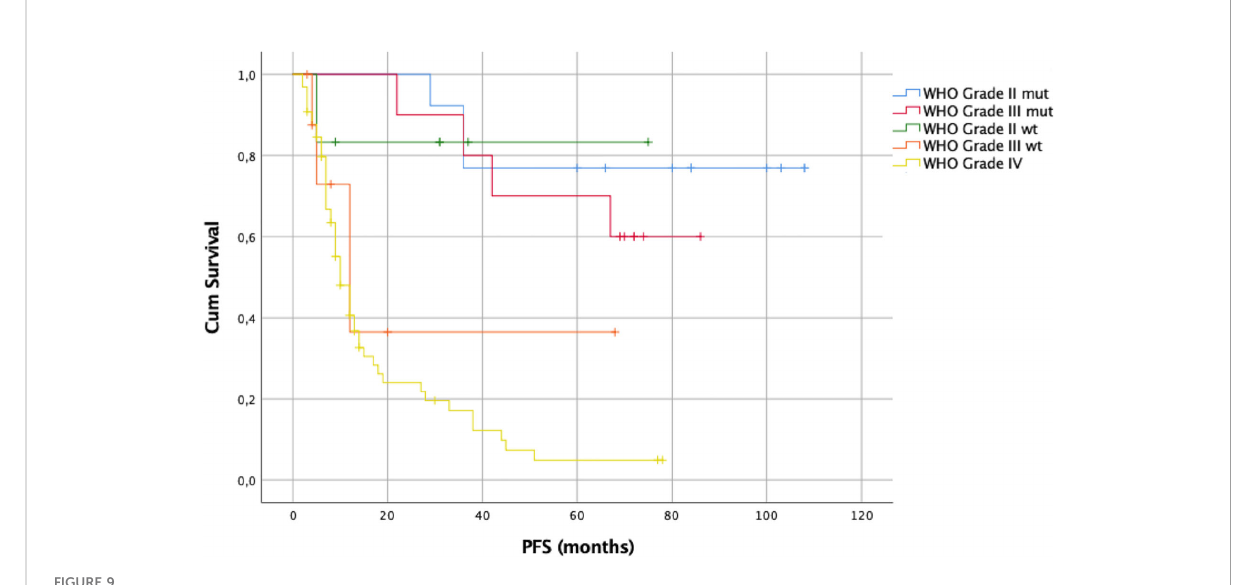
FIGURE 9 Kaplan – Meier curves of PFS of patients at fi rst resection.